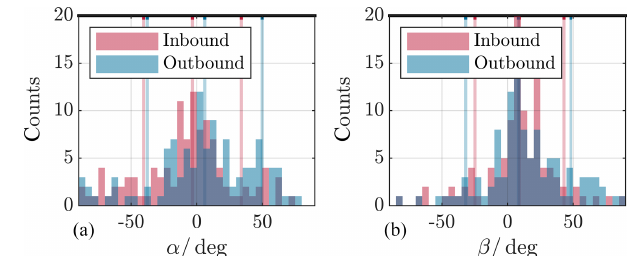
Figure 12. Deviation angle between model and data normal direc- tion as projected onto yz GSM plane (polar plane) (a) , and as pro- jected onto xy GSM plane (equatorial plane) (b) , for the outermost crossings. The distributions are separated by inbound (red) and out- bound (blue) passes. Indicated by the coloured vertical lines are the respective median angles as well as the standard deviations; see text. The meaning of the angle sign is explained in Fig.